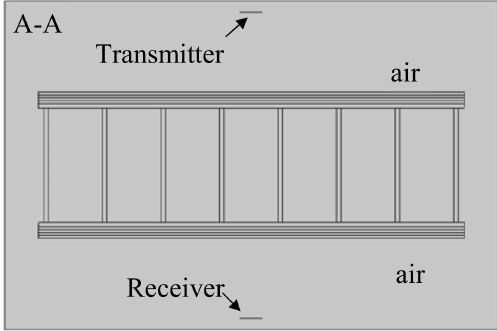
Figure 3. The two-dimensional model of honeycomb sandwich